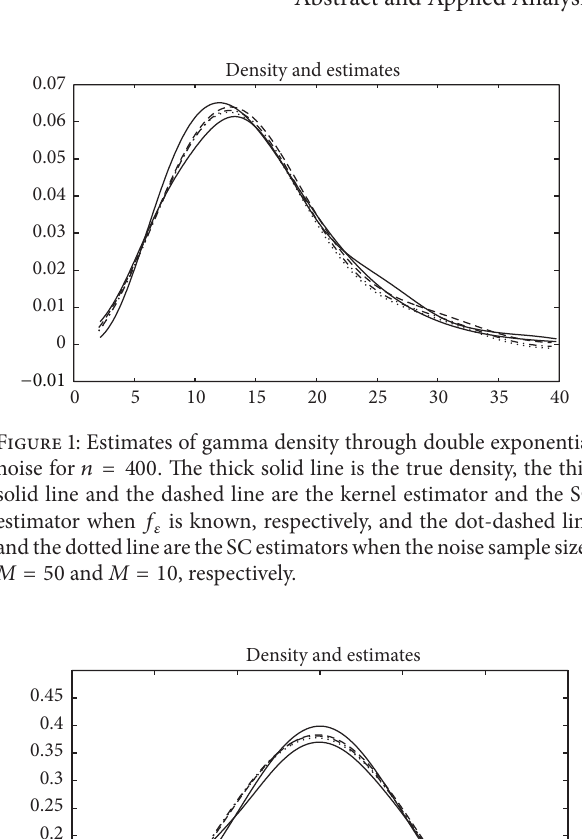
dashed and dot-dashed lines denote the case of 𝑁(0, 𝜎 2 ) measurement errors with 𝜎 = 0.3 and 𝜎 = 0.5 ,